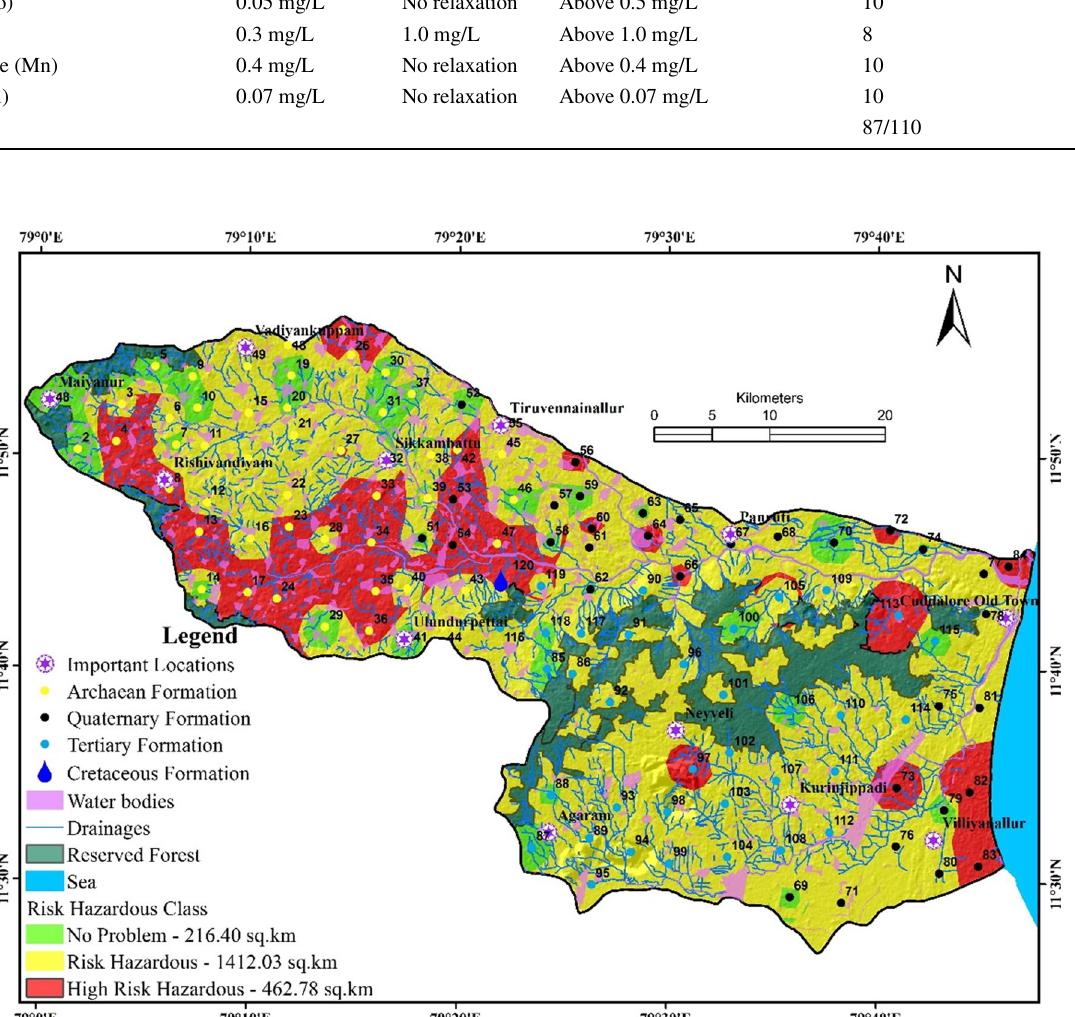
Fig. 15 Heavy metal health hazardous zonation